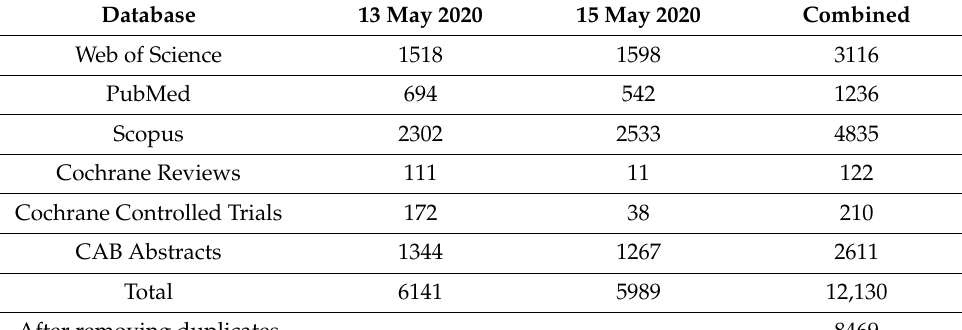
Table 1. The overall number of articles identified.